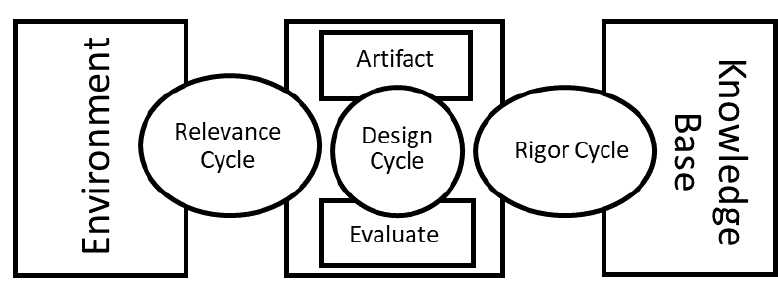
Fig. 1. Design Science Research Cycles